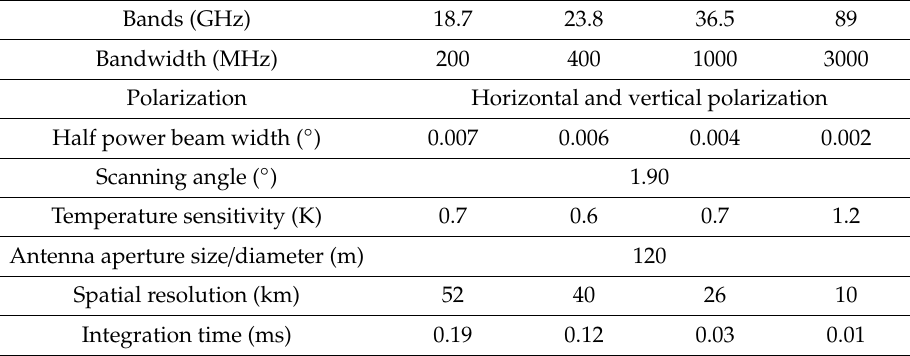
Table 1. The optimal parameters of the MBMR system.